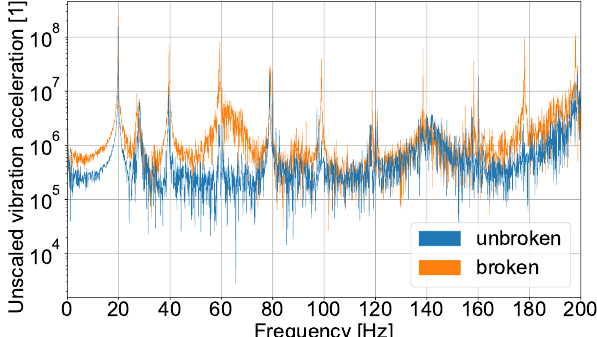
Figure 9. FFT of vibration measurement signals with a BRB and an unbroken rotor bar when the machine was operating at 1200 RPM and under 50% loading. The frequency range is limited to 0–200